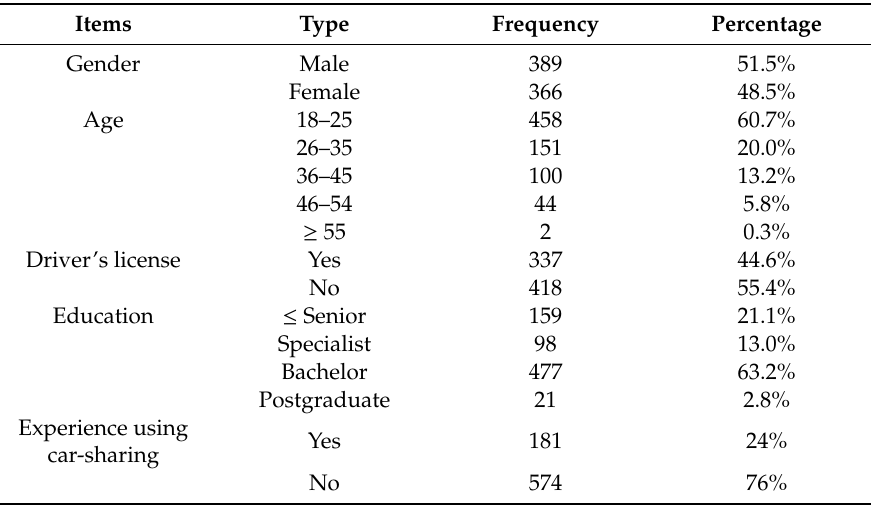
Figure 3. Figure 3 . The stratified sampling region. Table 2. Sample